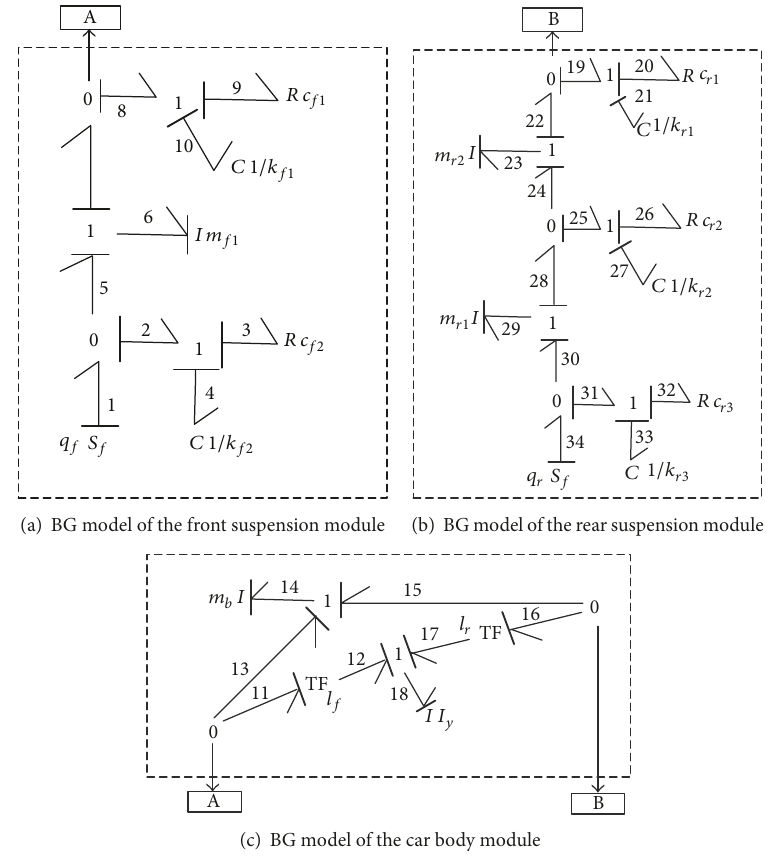
Figure 3: BG model of three submodules.